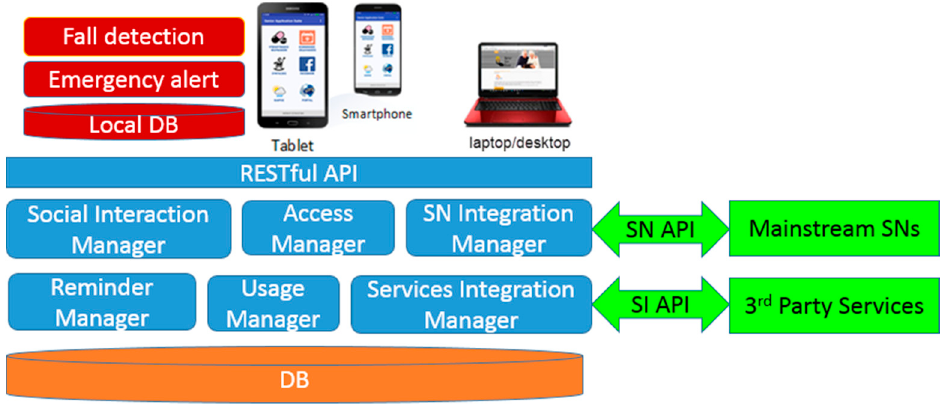
Figure 12. System architecture.